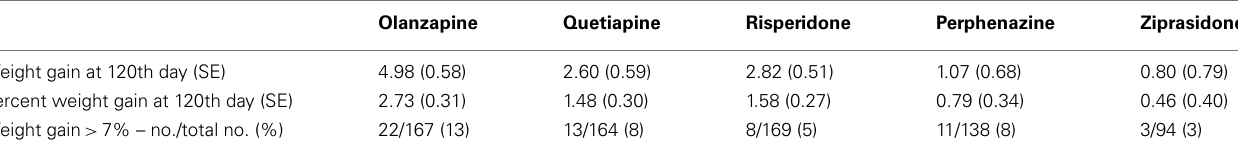
Table 3B |Weight measures after adjusting for covariates (Model 1: weight gain was estimated using combined data for all